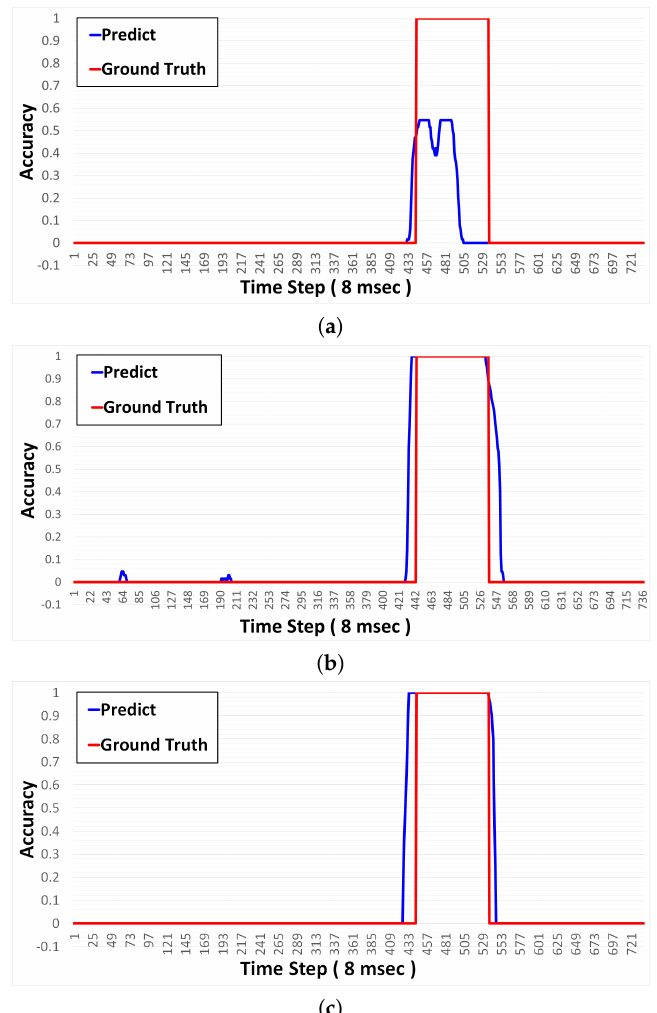
Figure 15. Network prediction results example. ( a ) is CNN prediction, ( b ) is RNN prediction and ( c ) is GRU